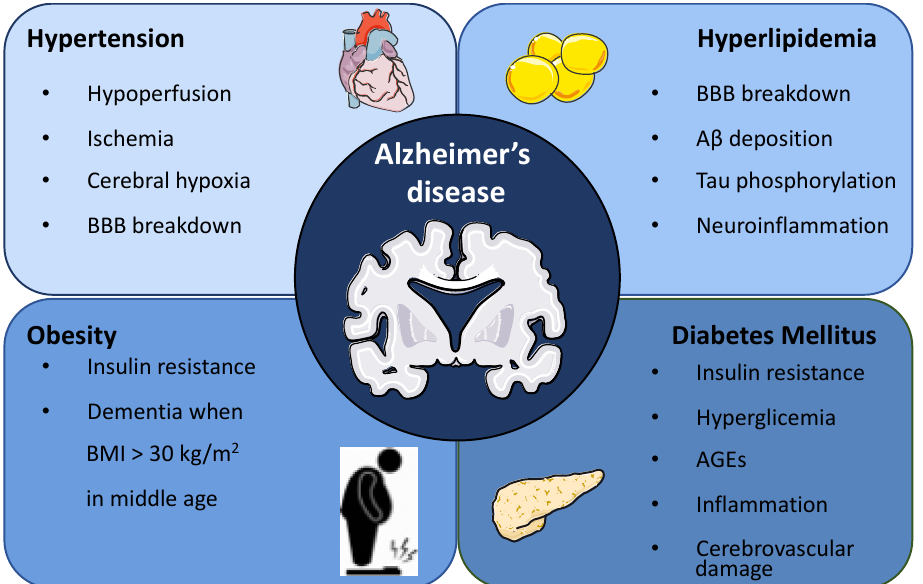
Figure 1. Metabolic syndrome as a risk factor for Alzheimer’s disease. Metabolic syndrome is defined as the coexistence of obesity, hypertension, hyperlipidemia and diabetes. Specifically, hypertension alters the vascular walls leading to hypoperfusion, ischemia and cerebral hypoxia, triggering AD development. Hyperlipidemia compromises BBB integrity, increases A β peptide deposition, promotes Tau hyperphosphorylation and induces neuroinflammation compatible with AD. The involvement of obesity as a risk factor for AD development is still under debate, although some studies have demonstrated that obesity in middle age is a risk factor for dementia. The association between diabetes mellitus (DM) and AD has been extensively studied. The suggested mechanisms underlying this association include, among others, insulin resistance, insulin receptor impairment, hyperglycaemia-induced toxicity, advanced glycation end products (AGEs)-induced adverse effects, inflammation and cerebrovascular damage.